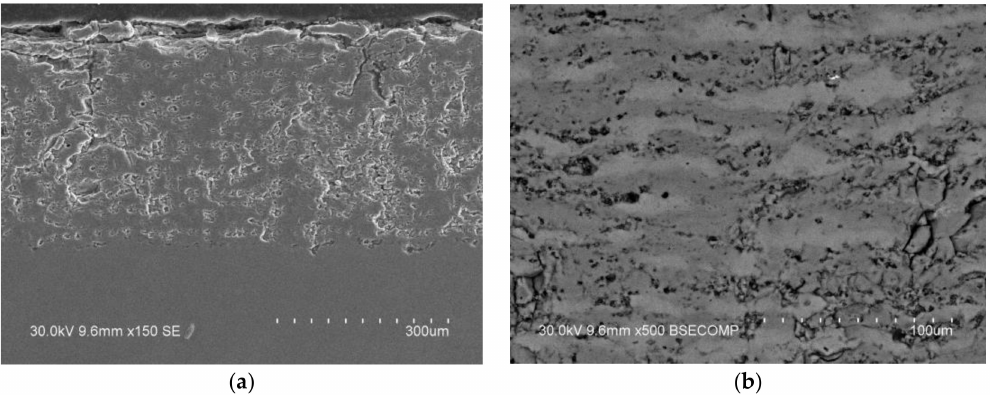
Figure 16. Cross-sectional view ( a ) and microstructure ( b ) of the deposits obtained from titanium at k = 1.1 using nitrogen as a carrier gas and an explosive charge of 60%; nitrogen (33 vol. %) was introduced into the mixture of O 2 + C 2 H 2 (reprinted from [29], Copyright (2015), with permission from Elsevier).